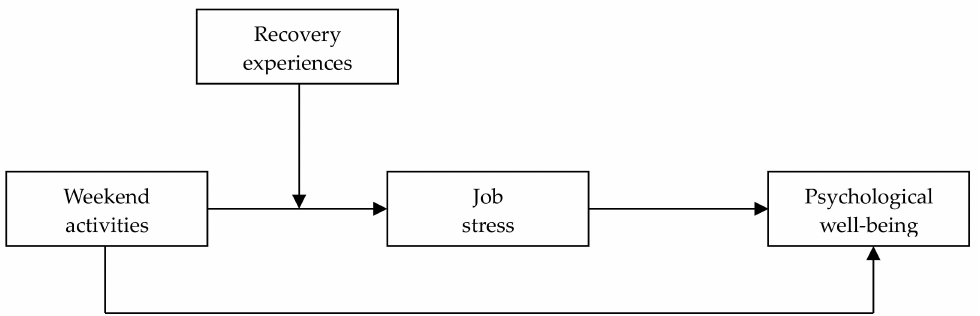
Figure 1. Hypothesized research